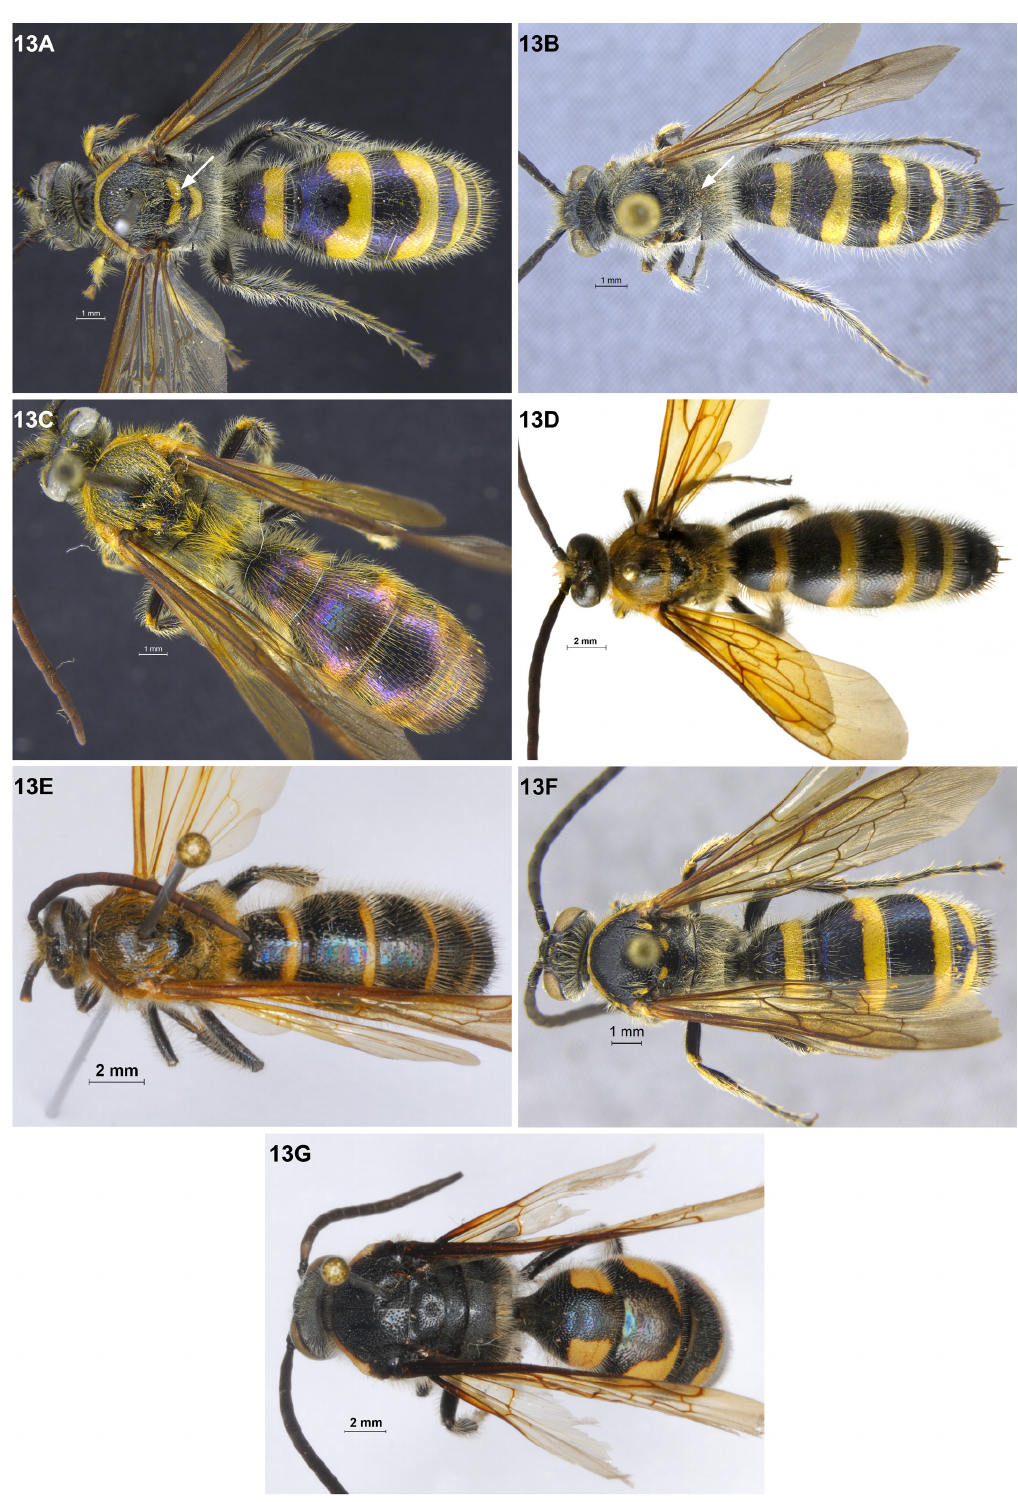
Fig. 13. Males, dorsal habitus. A . Campsomeriella annulata annulata (Fabricius, 1793). B . Camps. collaris (Fabricius, 1775). C . Megacampsomeris sp. 1. D . Megacam. formosensis chinensis Betrem, 1941. E . Megacam. prismatica (Smith, 1855). F . Phalerimeris phalerata phalerata (de Saussure, 1858). G . Sericocampsomeris flavomaculata Gupta & Jonathan,